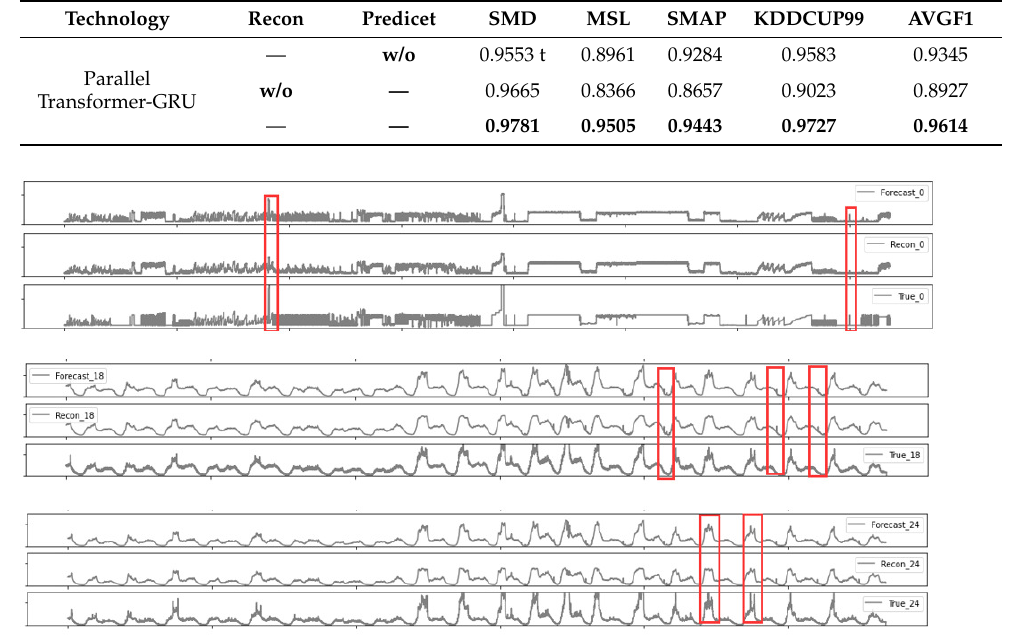
Table 6. Ablation results (F1) on different datasets based on reconstruction and prediction methods.